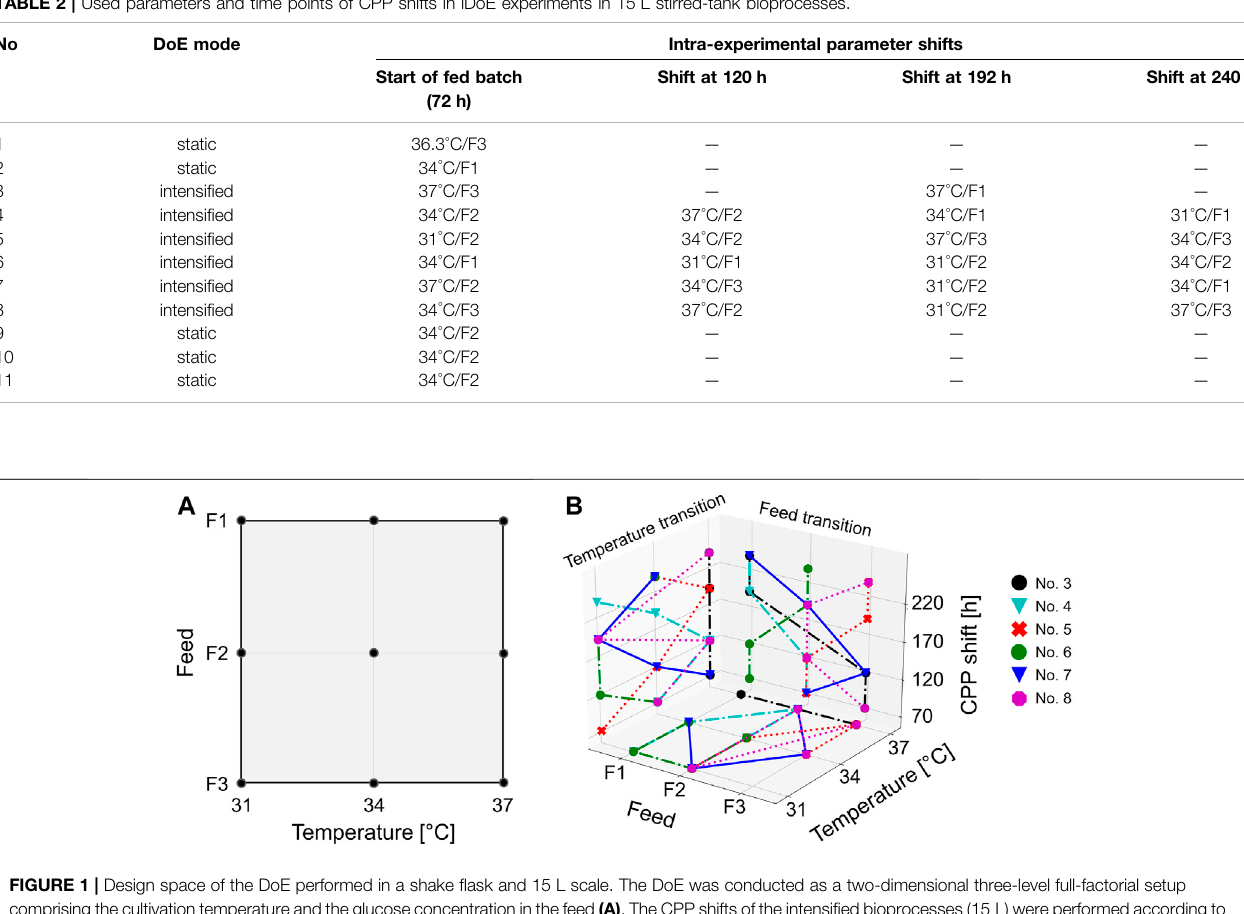
Frontiers in Bioengineering and Biotechnology |